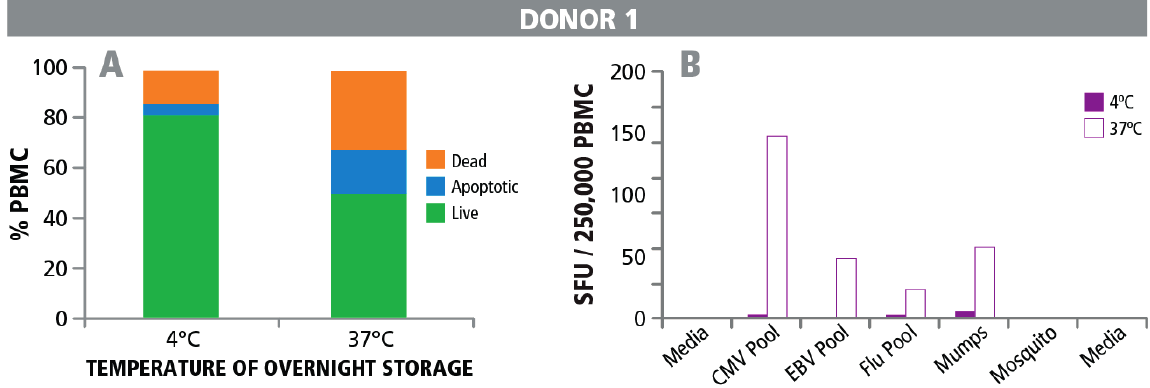
Figure 5. Percentage of live, dead, and apoptotic T cells, and T cell functionality after storing PBMC at 4 °C or 37 °C overnight. PBMC were stored at 4 °C or 37 °C overnight. ( A ) The numbers of live, dead, and apoptotic cells was determined after overnight storage. ( B ) PBMC stored overnight at 4 °C (solid bars) and 37 °C (open bars) were resuspended in fresh medium and tested in an IFN- γ ELISPOT assay with different antigens. CMV peptide pool, EBV peptide pool, and Flu peptide pool were used to activate CD8 cells and Mumps and